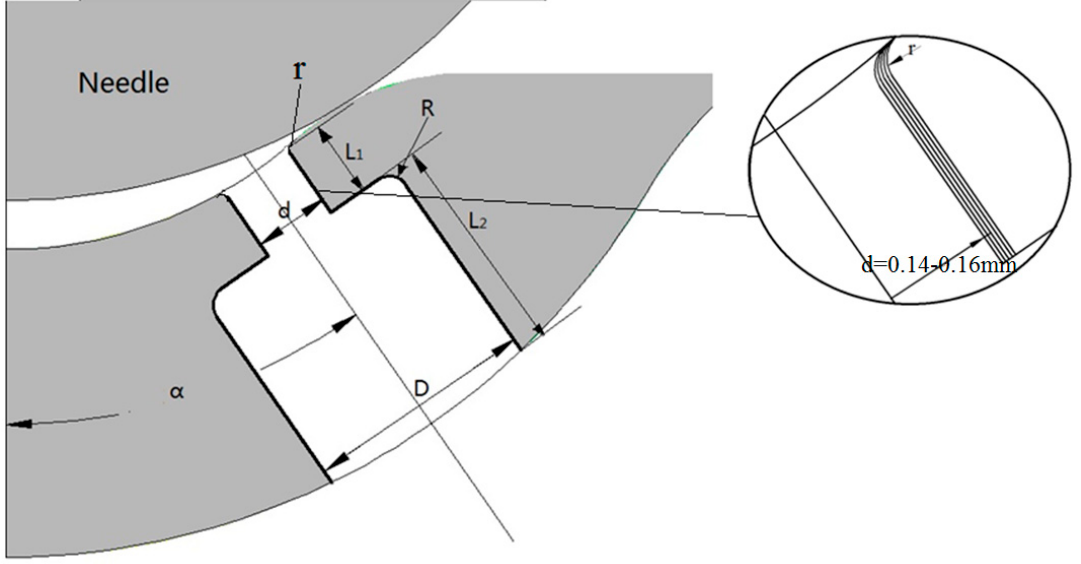
Figure 2. Structural parameters of the GDI injector nozzle. Figure2. Structural parameters of the GDI injector nozzle. Table 1. Boundary conditions, nozzle sizes, and mathematical Table 1. Boundary conditions, nozzle sizes, and mathematical models.